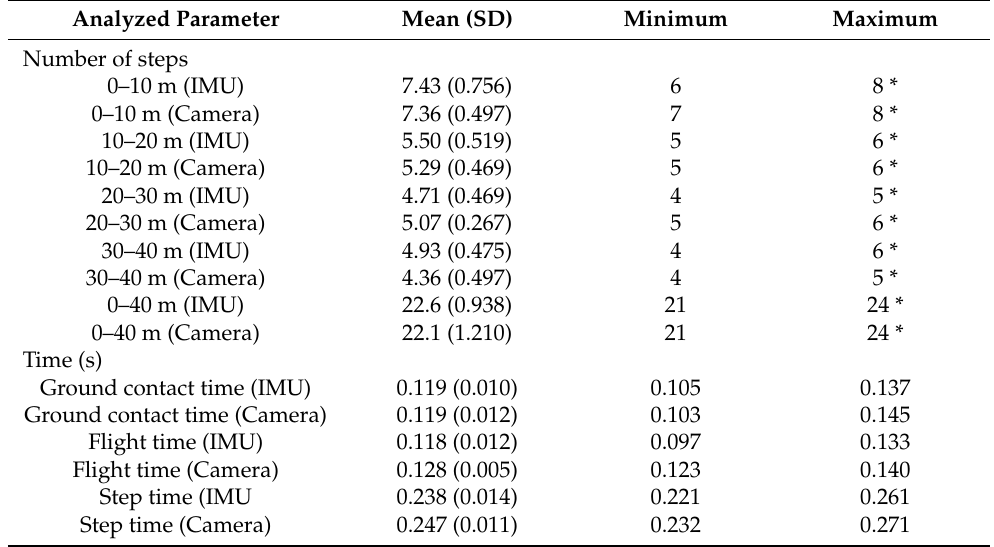
Table 1. A descriptive comparison between the inertial measurement unit (IMU) and high-speed camera. Analyzed